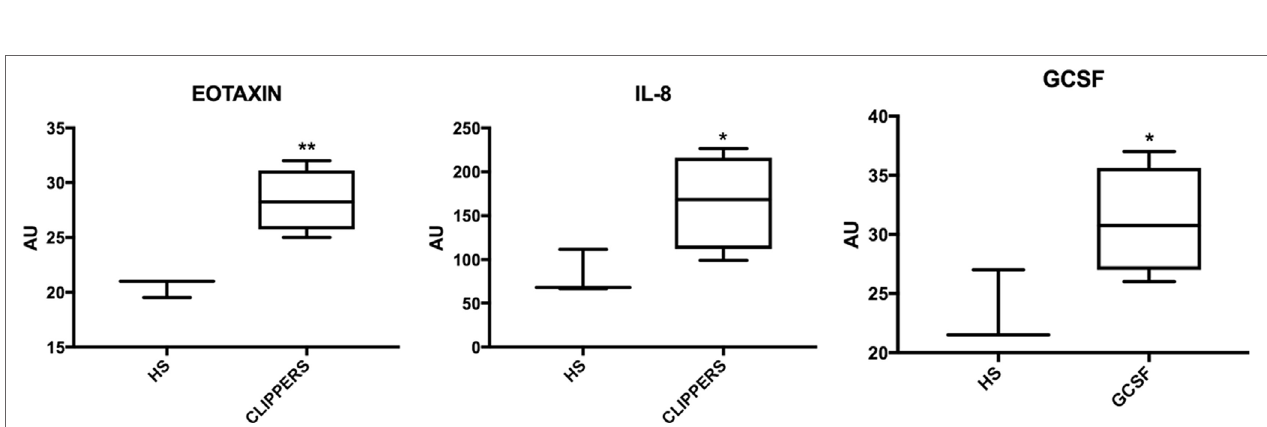
FigUre 5 | Molecular markers in the cerebrospinal fluid of patients with chronic lymphocytic inflammation with pontine perivascular enhancement responsive to steroids (CLIPPERS) compared to healthy subjects. Box-plots of molecular markers significantly upregulated in CLIPPERS CFS from patients #1–4 compared to healthy subjects (HS; n = 3) using the semi-quantitative RayBiotech human inflammatory assay. * p < 0.05; ** p < 0.01 using Student’s t -test.